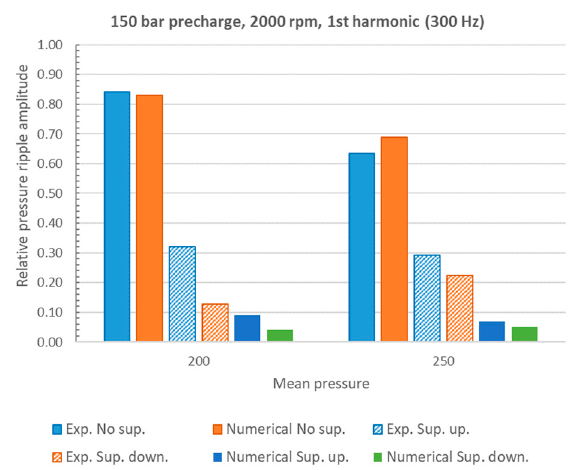
Figure 10. FFT of the pressure ripple, 2nd harmonic, pump speed = 1500 rpm.